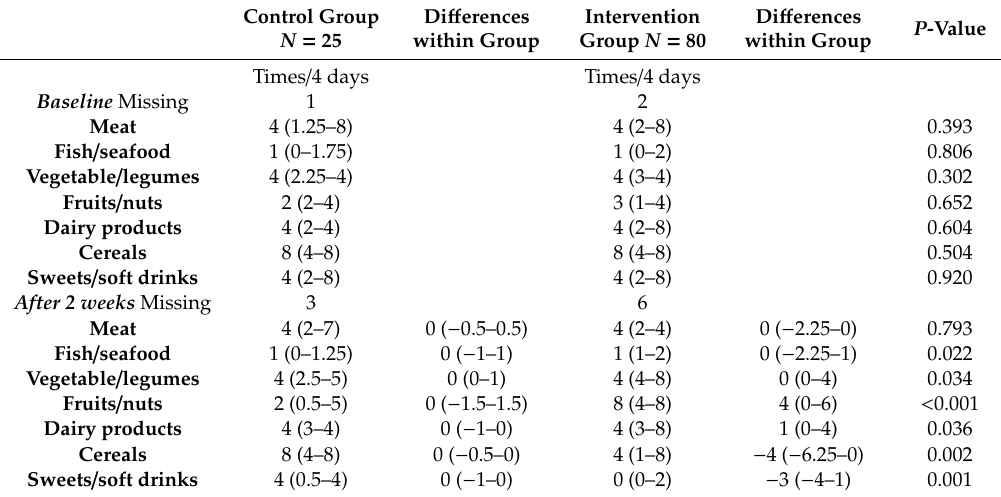
Table 1. Dietary intake before and after 2